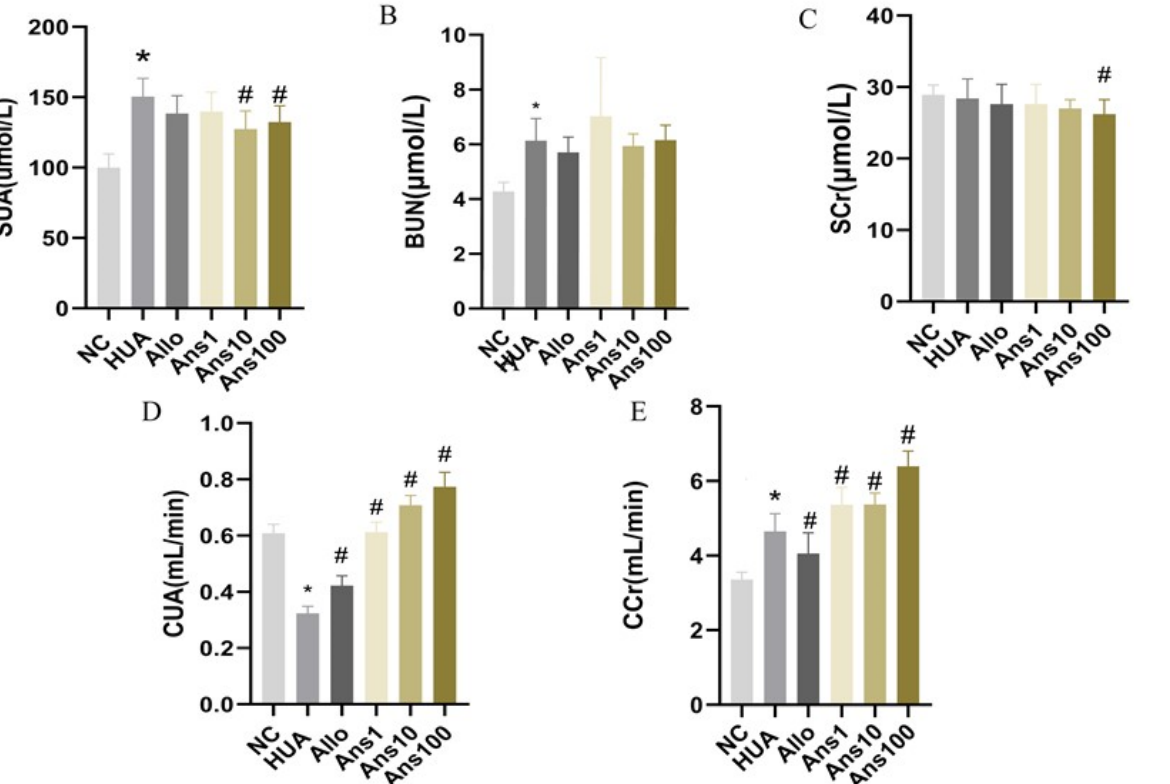
Figure 1. Effect of anserine on hyperuricemia-related indicators. The level of serum ( A ) SUA(serum uric acid); ( B ) BUN (blood urea nitrogen); ( C ) SCr (serum creatinine); ( D ) CUA (uric acid clearance); and ( E ) CCr(creatinine clearance); * p < 0.05 indicates that the difference is significant when compared with the NC group. # p < 0.05 indicates that the difference is significant when compared with the HUA group.